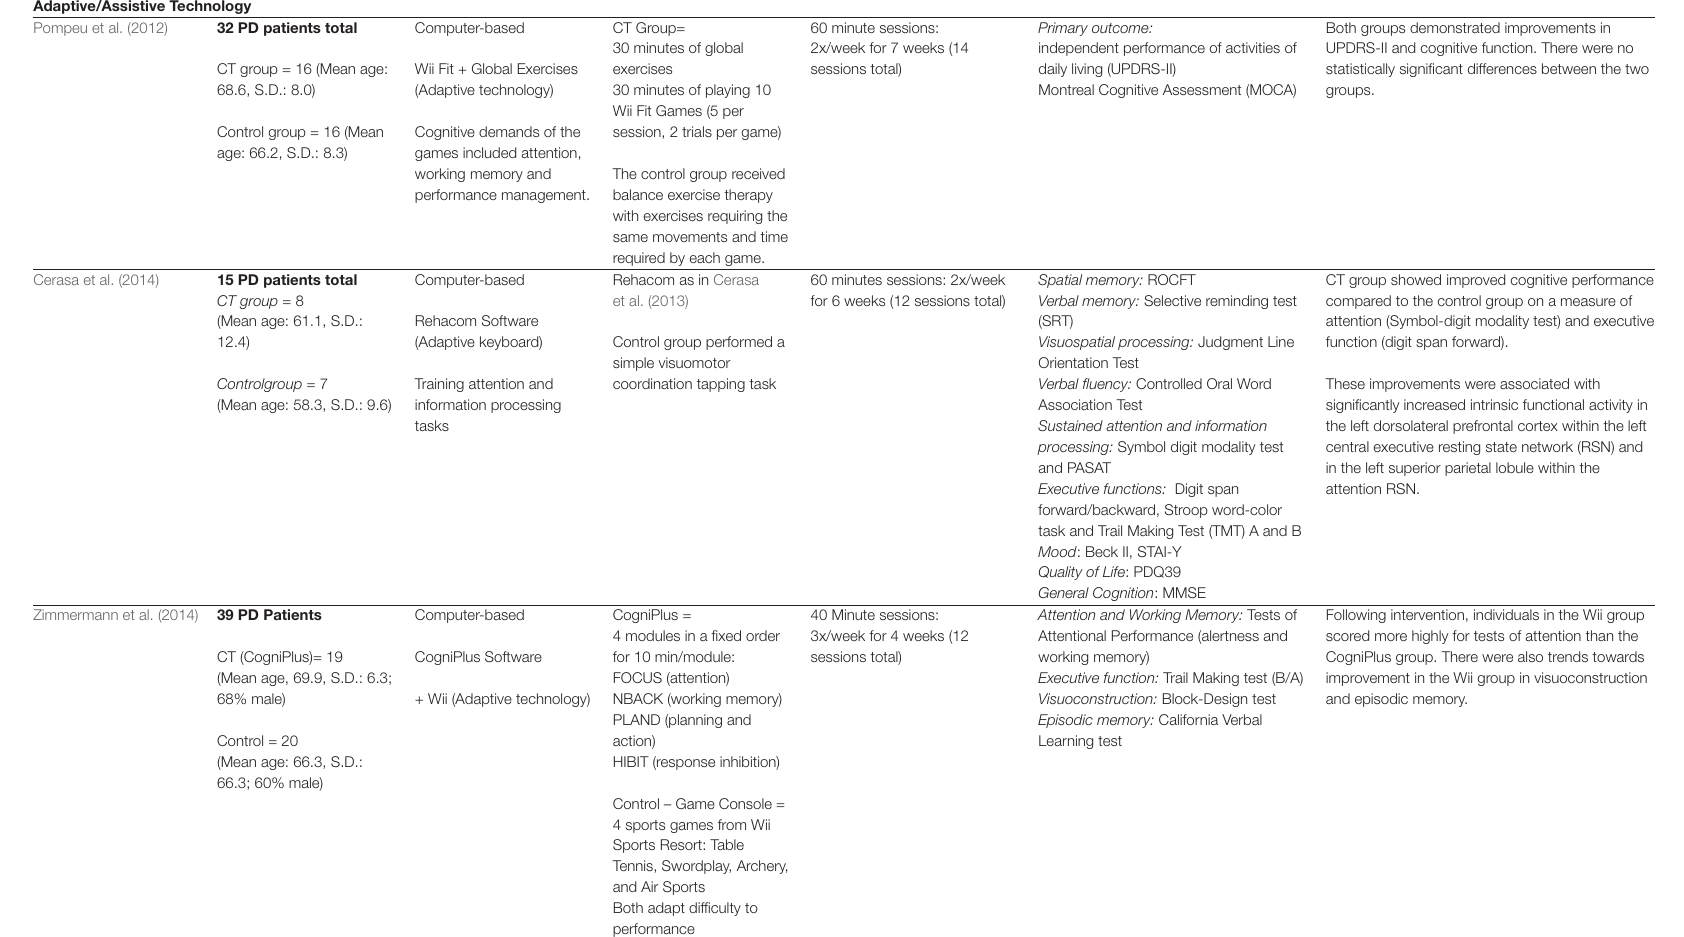
TABLE 1 | (Continued) Adaptive/Assistive Technology Pompeu et al. (2012)